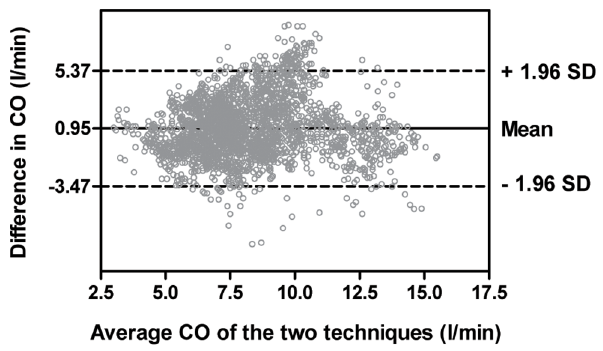
Fig 1. The Bland-Altman plot shows wide 95% limits of agreement between bioreactance and thermodilution in cardiac output